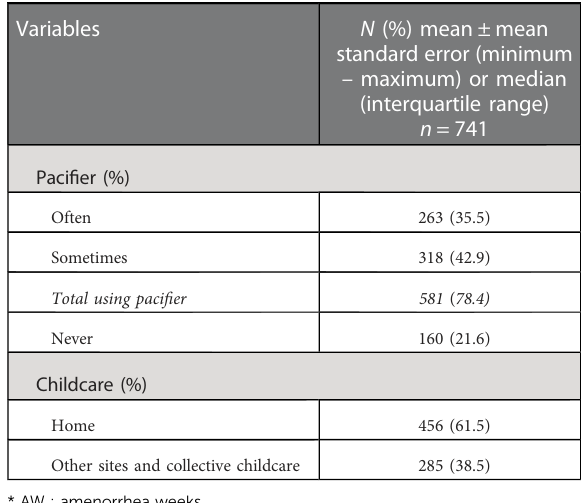
TABLE 1 Description of the child